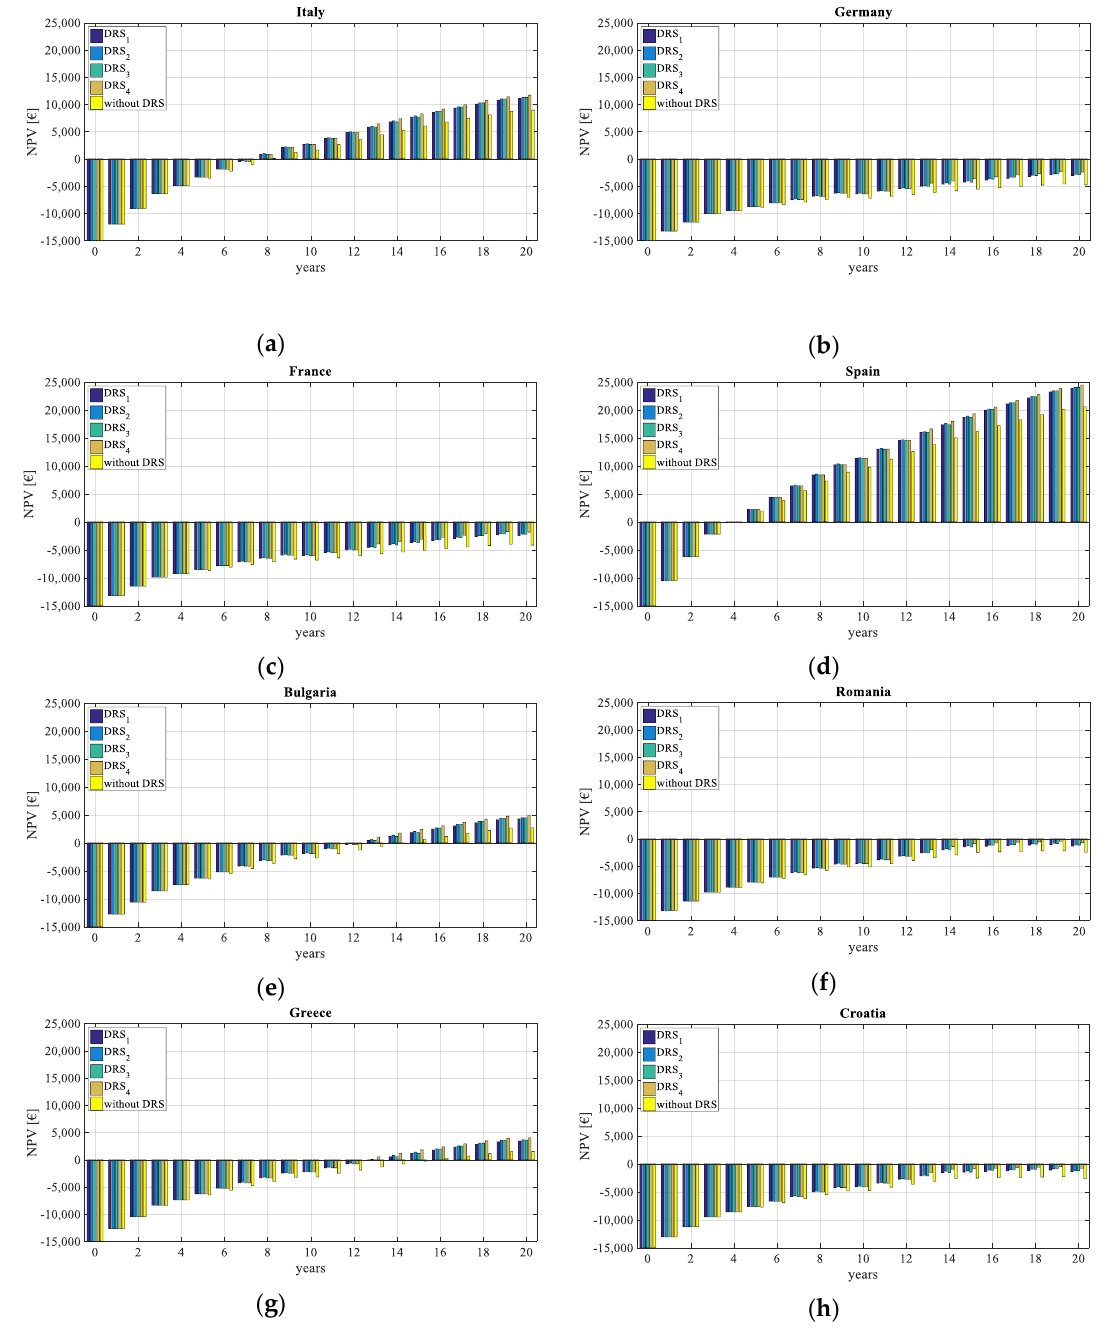
Figure 12. NPV trend over the time of four cases of DRS 1-4 and without DRS, in ( a ) Italy, ( b ) Germany, ( c ) France, ( d ) Spain, ( e ) Bulgaria, ( f ) Romania, ( g ) Greece and ( h ) Croatia.